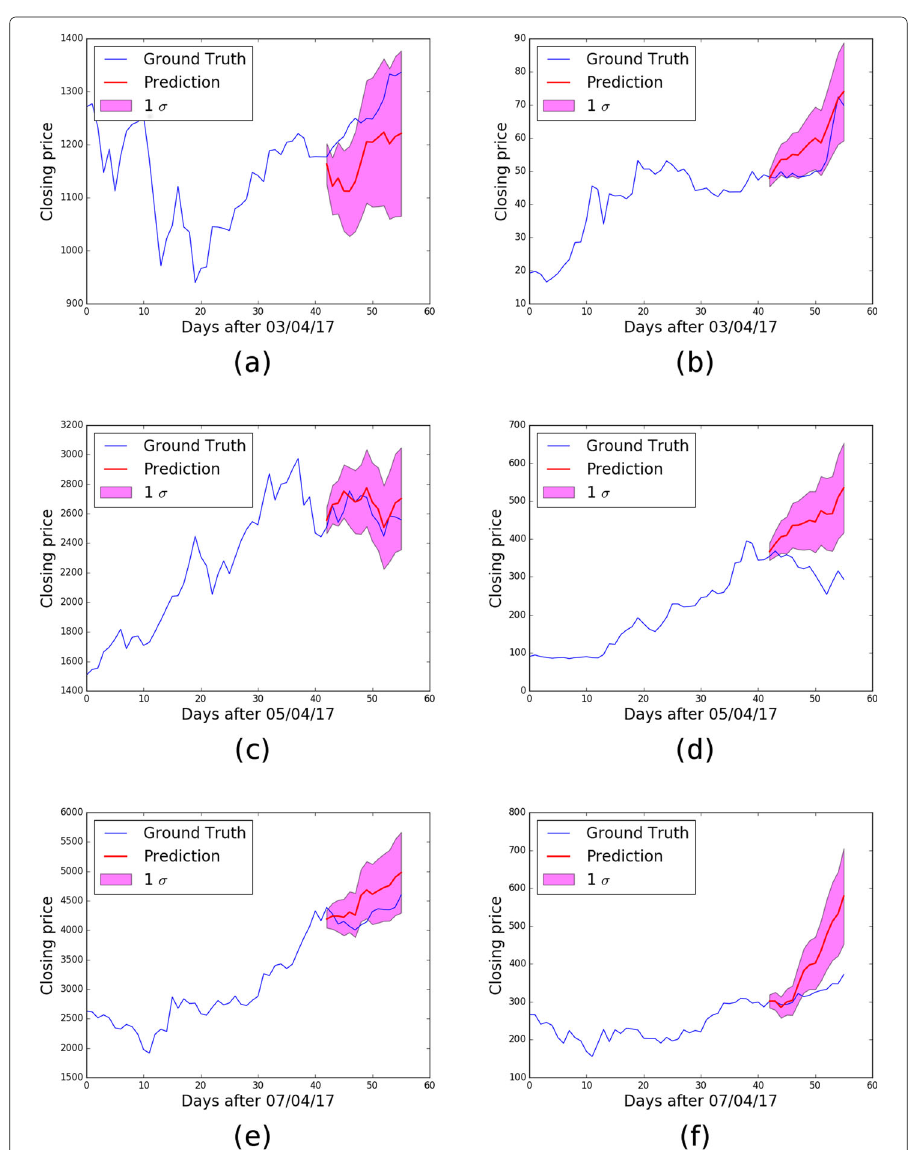
Fig. 6 Each subfigure shows 14 days of prediction compared to the ground truth with the previous 14 days of ground truth as reference. ( a , b ) shows the prediction at the end of April 2017. ( c , d ) shows the prediction at the end of June 2017. ( e , f ) shows the predictions at the end of August 2017. ( a , c , e ) shows the predictions for Bitcoin at the corresponding time ranges and ( b , d , f ) for Ethereum. Mape values for each subfigure can be seen in Table 2. Estimated parameters and correlations for these examples can be seen in Table 5 (Appendix 4)